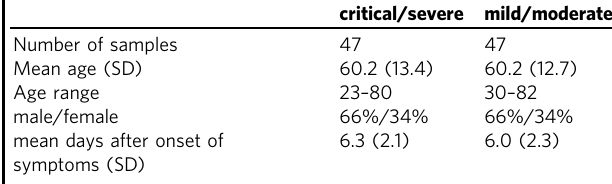
Table 1 Sample characteristics of the 2 nd